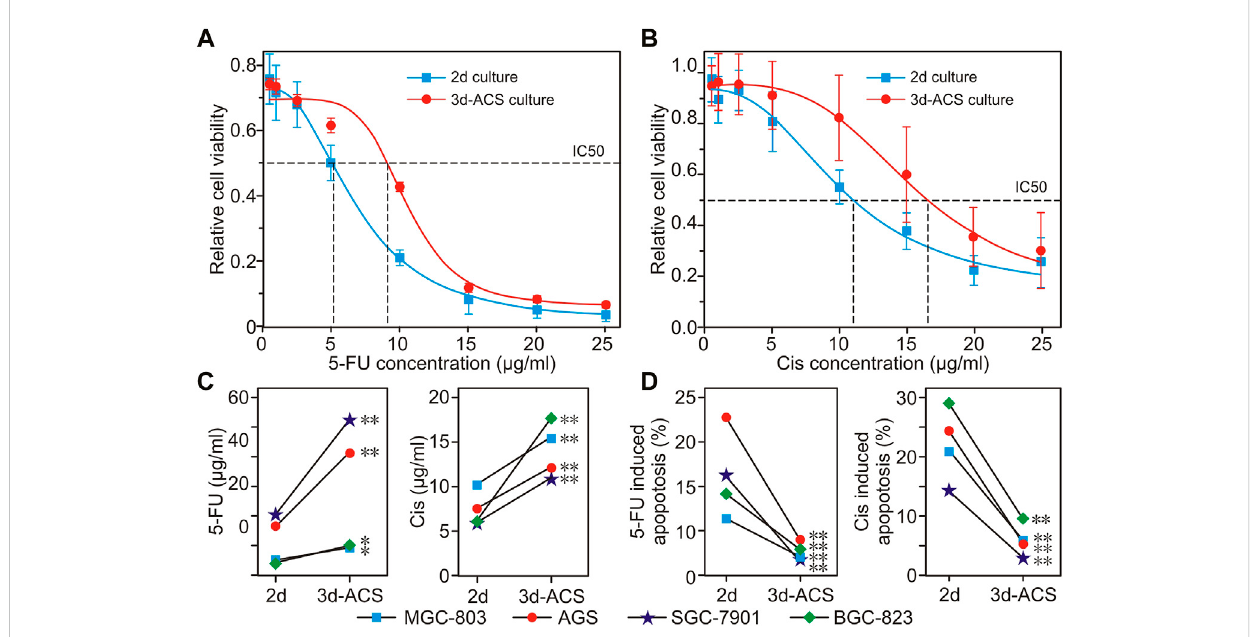
FIGURE 4 ThedrugresponsesofGCcellsto5-FUandcisplatinculturedinnormoxiaof2ddishand3d-ACS. (A,B) ThereactivechangesofMGC-803cellsto5- FUandcisplatinthatculturedin3d-ACSand2ddishfor48 h. (C) In2dor3d-ACSconditions,fordifferentGCcelllines,theIC50variationsofGCcellto5- FU and cisplatin. (D) Under different conditions (2d or 3d-ACS), the GC cell apoptosis is induced by 5-FU or cisplatin. n = 3 per group, *: p < 0.05, **: p <